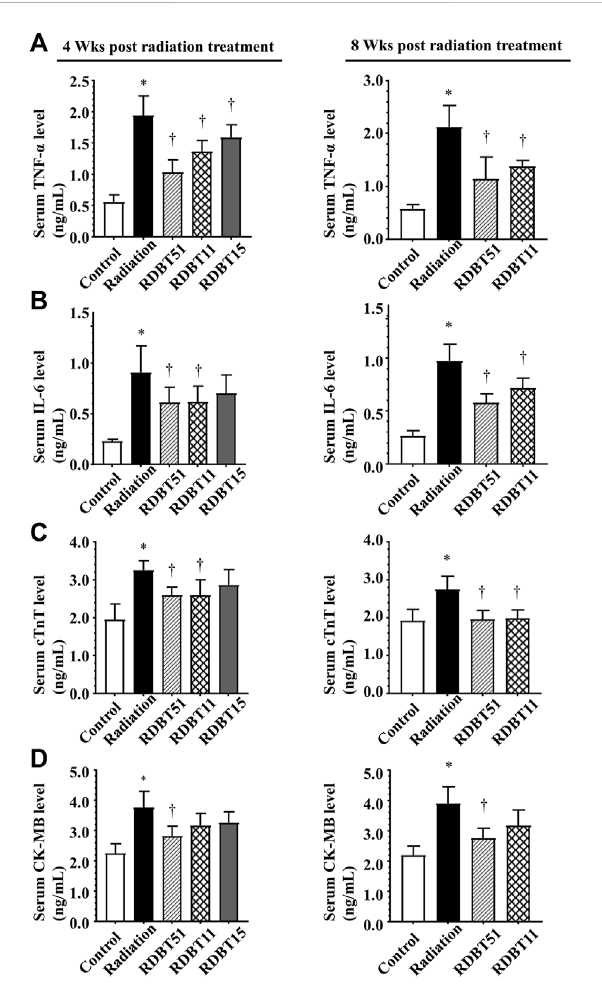
FIGURE 2 The DBT ameliorates the in fl ammation- and myocardial injury- related biomarkers in the serum of mice at 4 and 8 weeks after radiation. (A) TNF- α ; (B) IL-6; (C) cTnT; (D) CK-MB. * p < 0.05 versus Control; † p < 0.05 versus Radiation. DBT, Dang Gui Bu Xue Tang; RAM, Radix Astragali membranaceus ; RAS, Radix Angelicae sinensis ; RDBT51, Radiation with DBT (RAM: RAS = 5:1); RDBT11, Radiation with DBT (RAM: RAS = 1:1); RDBT15, Radiation with DBT (RAM: RAS =